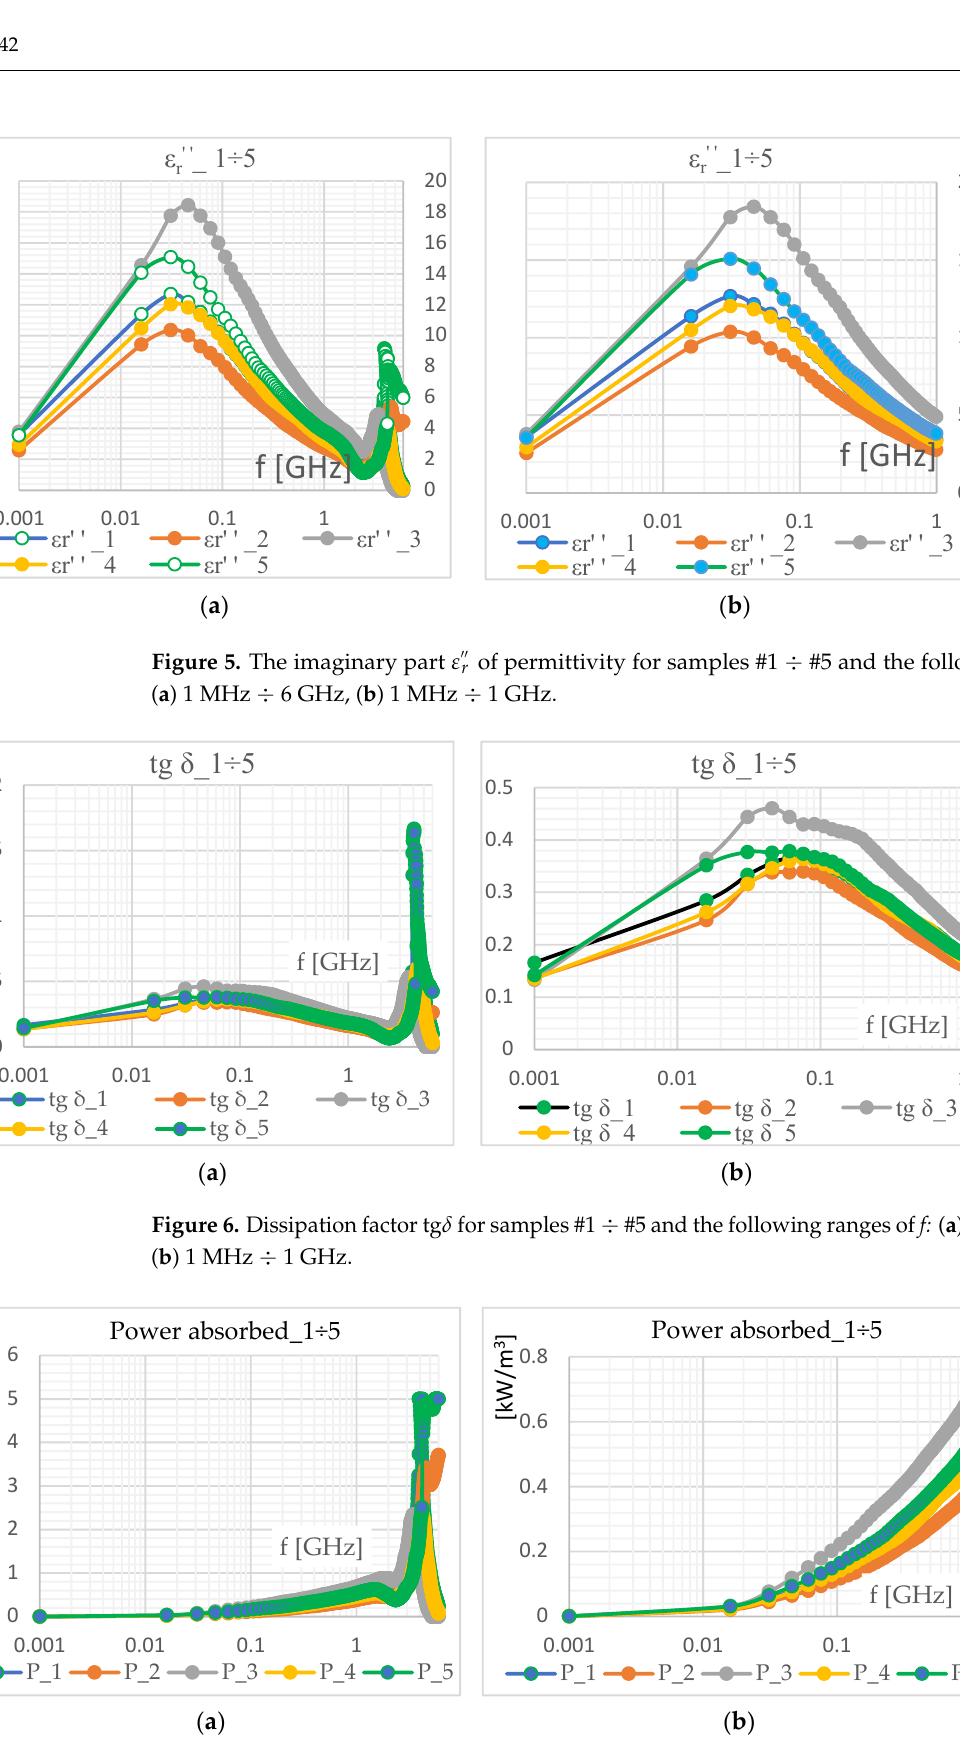
Figure 7. Power density per unit volume P [KW/m 3 ] for samples #1 ÷ #5 and the following ranges of f: ( a ) 1 MHz ÷ 6 GHz, ( b ) 1 MHz ÷ 1 GHz.